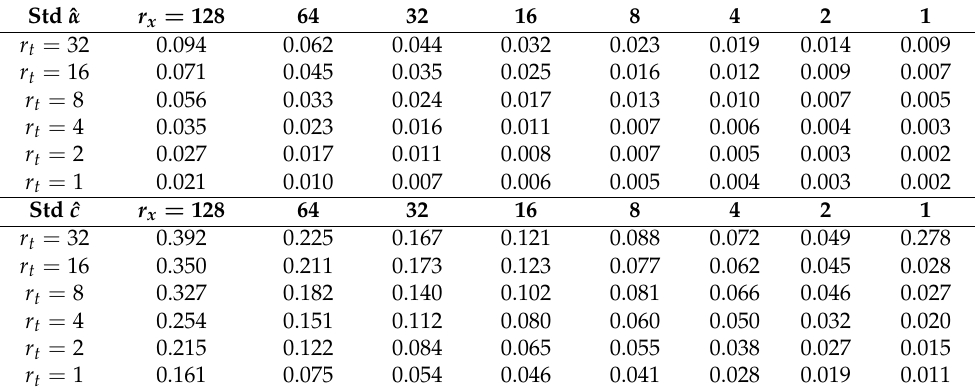
Table 2. Two-parameter estimation: Standard deviation (std) of the estimated ( α , c ) from 20 different full observations. The effect of sparsity of observation on the std of the estimated parameters is demonstrated. The noise magnitude is fixed to (cid:101) ∗ =